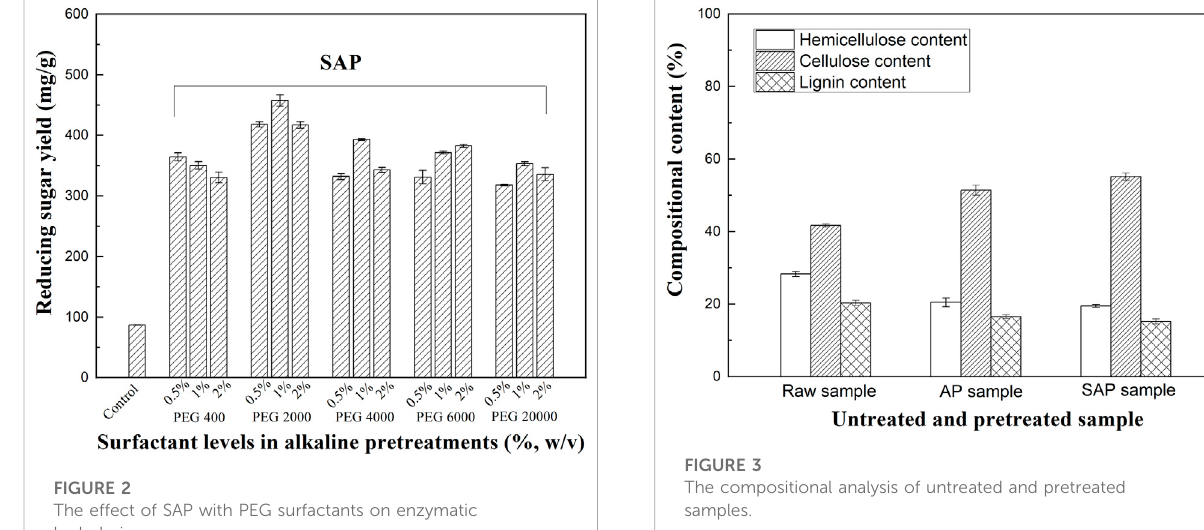
FIGURE 3 The compositional analysis of untreated and pretreated